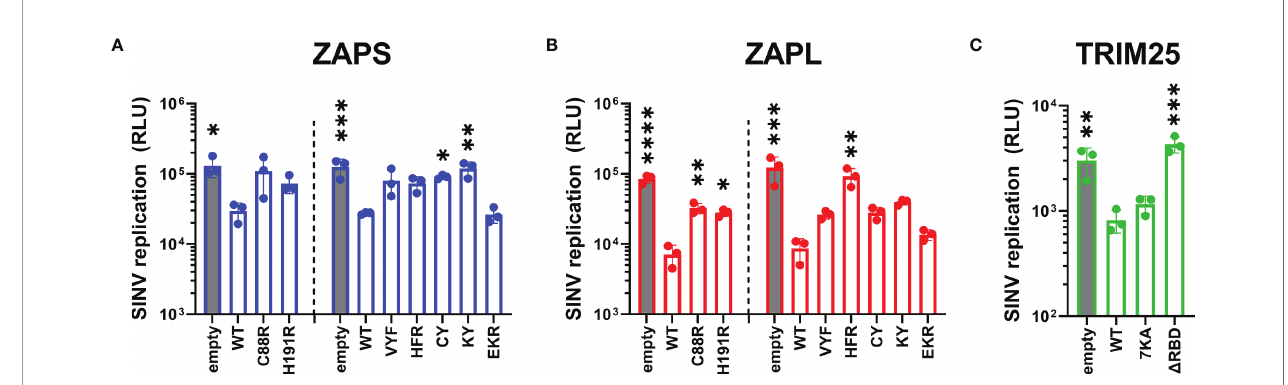
FIGURE 3 | Inhibition of SINV replication by ZAP and TRIM25 RNA binding mutants. (A, B) ZAP KO 293T cells or (C) TRIM25 KO 293T cells were transfected with (A) ZAPS RNA binding mutants, (B) ZAPL RNA binding mutants, or (C) TRIM25 RNA binding mutants, infected with SINV Toto1101/luc at an MOI of 0.01 PFU/cell, and lysed 24 hours post infection (h.p.i.) for measurement of luciferase activity. Different amounts of (A) ZAPS and (B) ZAPL WT were transfected to match protein expression levels for each subset of ZnF mutants and CpG RNA binding cavity mutants. Data from triplicate wells are representative of two independent experiments. Asterisks indicate statistically signi fi cant differences as compared to (A, B) ZAP WT or (C) TRIM25 WT within each subset of RNA binding mutants (by one-way ANOVA and Dunnett ’ s multiple comparisons test: *p < 0.05; **p < 0.01; ***p < 0.001; ****p < 0.0001). Unlabeled comparisons are not signi fi